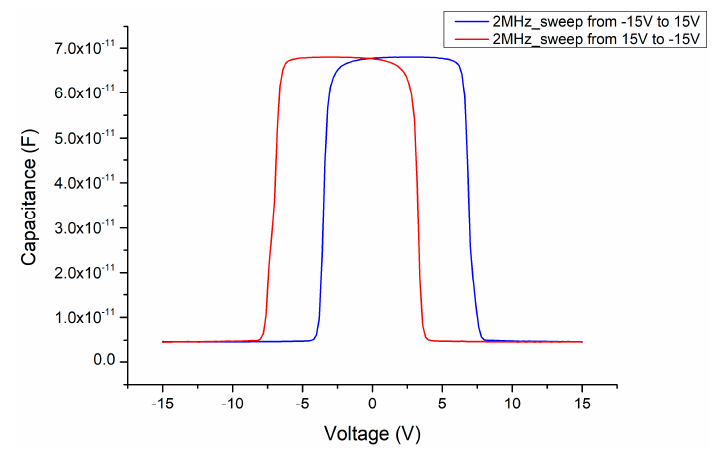
Figure 16. Threshold voltage of the MOSOM varactor.